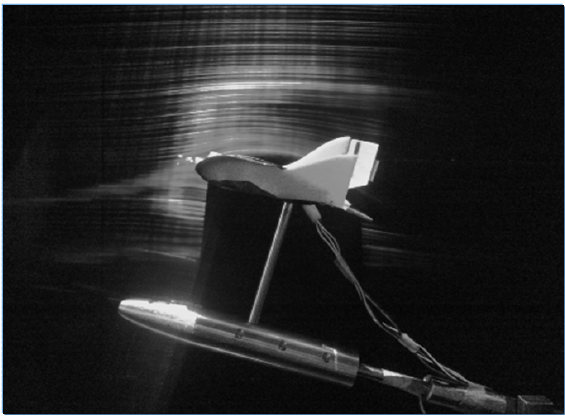
Figure 3. MAV undergoing wind tunnel tests.